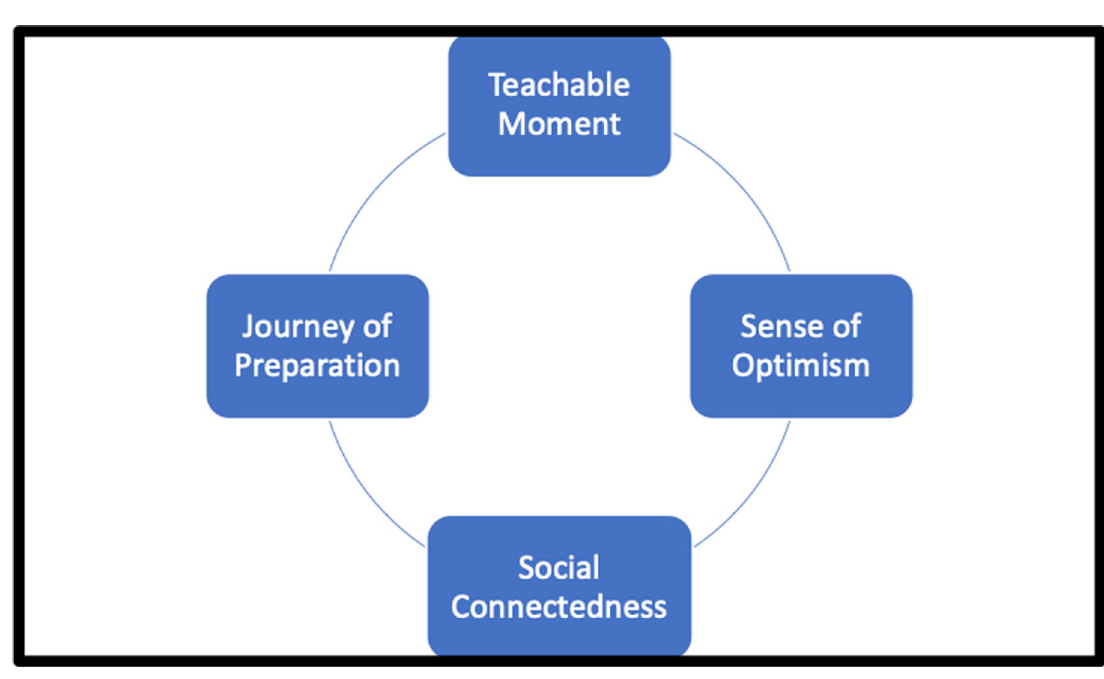
Fig 2. Illustration of main